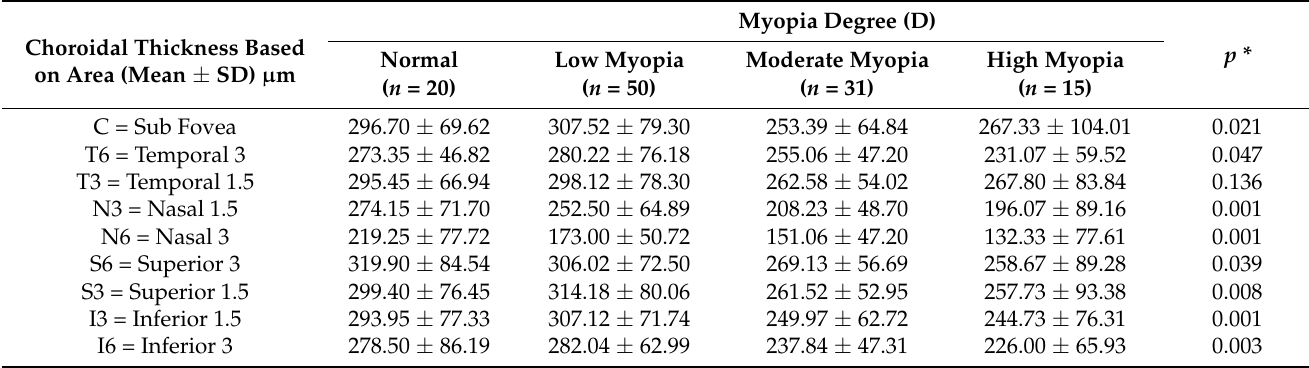
Table 1. Comparison of choroidal thickness and the degrees of